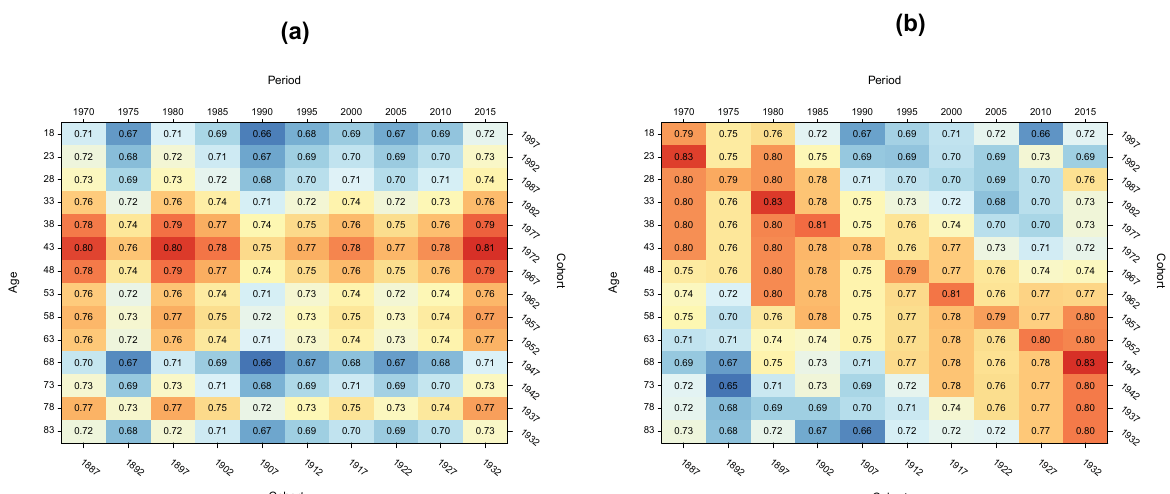
Figure 17: Two-dimensional Lexis heat maps of age–period and cohort–period nonlinearities. Notes: (a) displays a two-dimensional Lexis heat map of age and period nonlinearities, with calculations based on α i + π j for all observed combinations of i = 1, . . . , I and j = 1, . . . , J . (b) displays a two-dimensional Lexis heat map of cohort and period nonlinearities, with calculations based on combinations of k = 1, . . . , K and j = 1, . . . , J . All estimates are derived from a diachronic L-APC logistic (cid:101) (cid:101) regression model. Outcome is social trust, coded so that 1 = “can trust” while 0 = “can’t be too careful” or “depends.” Results adjusted using sampling